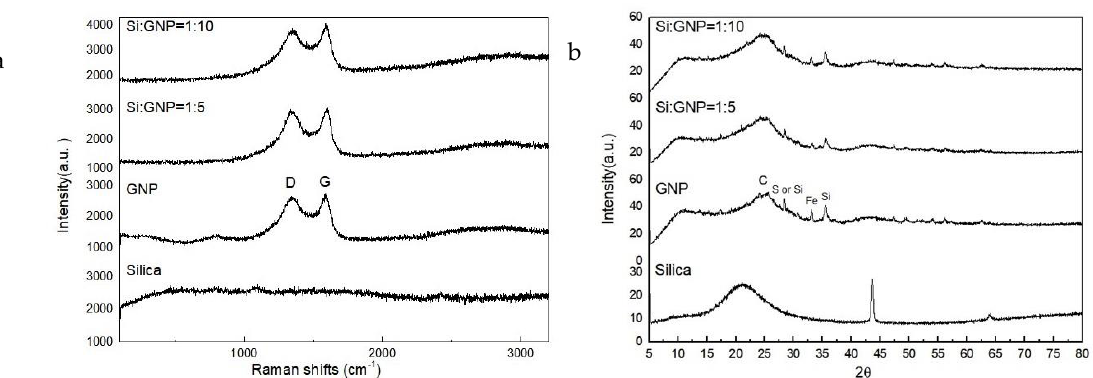
Figure 8. ( a ) Raman spectra and ( b ) XRD patterns of silica, GNP, and Si:GNP = 1:5 and Si:GNP = 1:10 hybrid additives